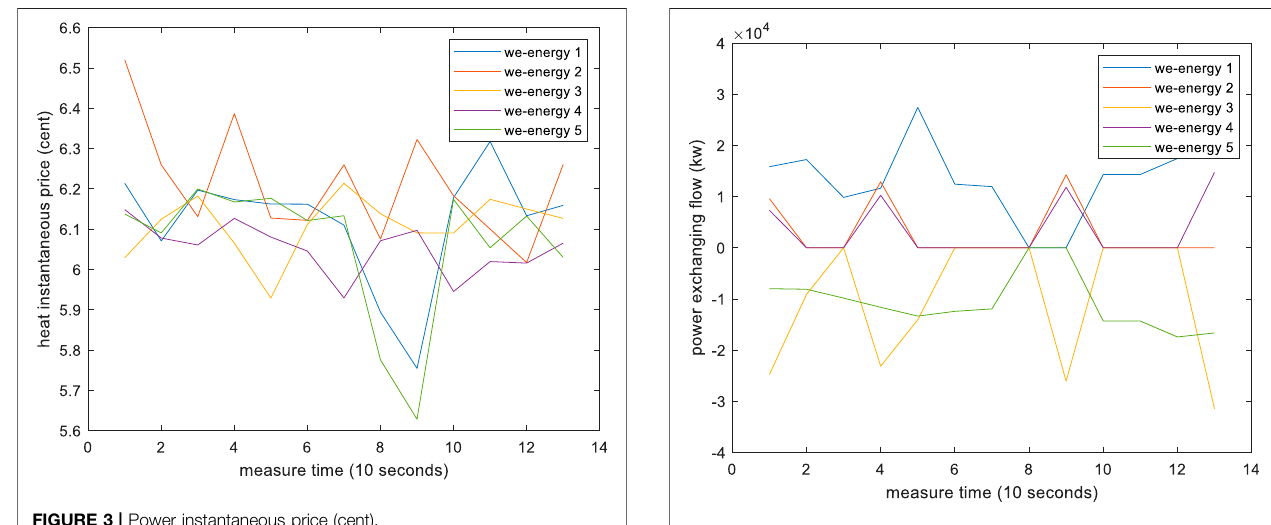
FIGURE 4 | Power exchanging fl ow (kw).